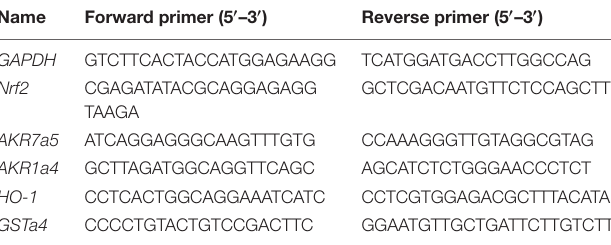
TABLE 1 | The sequences of primers used in real-time